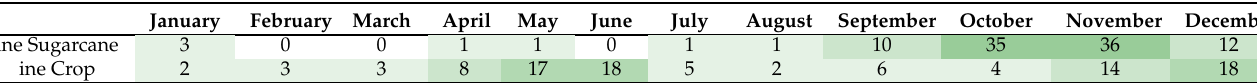
Table 1. Distribution of the start of growth dates throughout the year (percentages are reported) for annual crops and sugarcane fields.